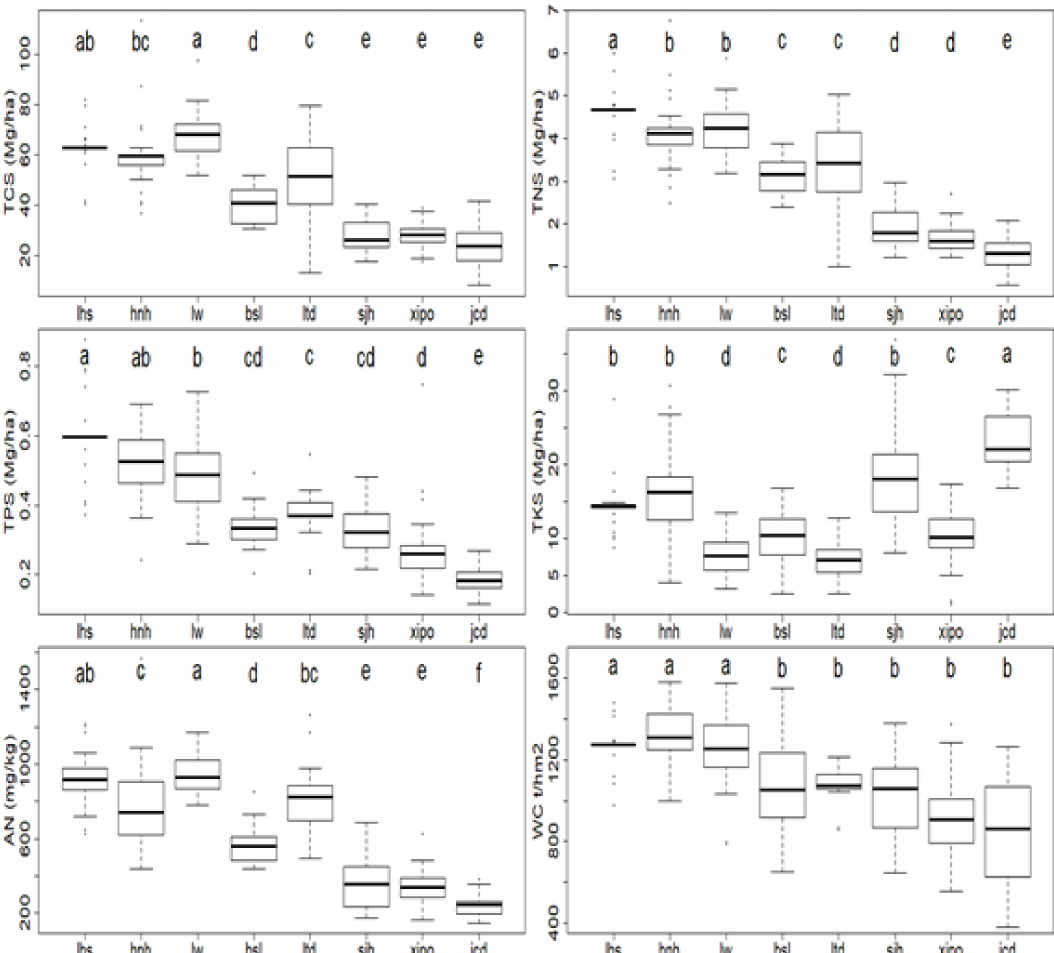
Figure 2. Soil nutrient status along the elevation gradient. Chemical properties include total carbon stock (TCS), total nitrogen stock (TNS), total phosphorus stock (TPS), total potassium stock (TKS), readily available nitrogen (AN), and soil capillary water retention (WC). Different letters (a–f) indicate significant differences among different sampling plots. Mg denotes